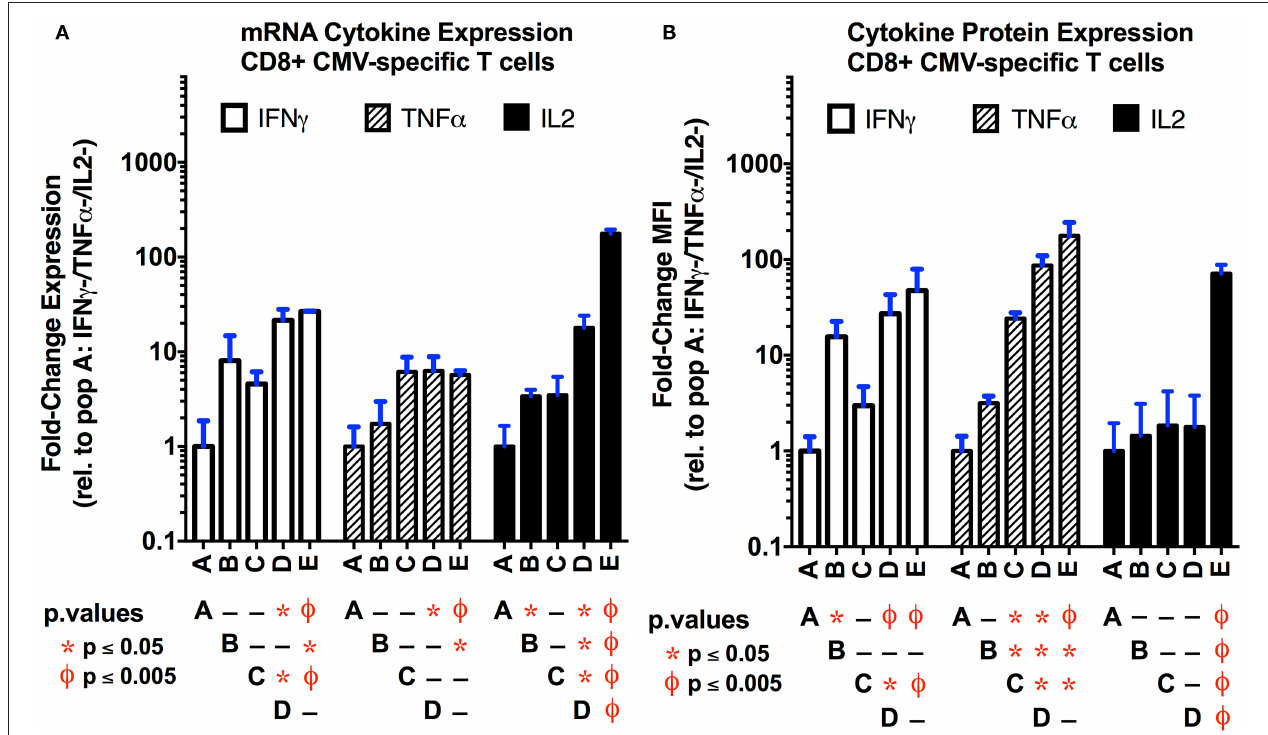
FIGURE 3 | Comparison of cytokine mRNA (A) and protein (B) expression levels in the functional subsets of CMV-specific CD8 + T cells. The mRNA transcript levels for the three primary type 1 cytokines (IFN γ , TNF α , IL-2) were obtained as normalized counts from total RNAseq data, and expressed as the fold-change (log 2 ) compared to the non-functional population ( A ; IFN γ -/TNF α -/IL-2-). The protein expression level (B) was obtained by flow cytometry following intracellular staining for the three cytokines of interest. Data are expressed as the fold-change in mean fluorescence intensity (MFI) relative to the non-functional population ( n = 3 per subset; error bars represent SD). Overall, there is good correlation between the mRNA and protein expression levels. This suggest that, in single cell experiments, the transcription data may be useful to identify functional subsets. Statistical testing: φ p < 0.005; * p < 0.05. Populations: (A) non-functional (IFN γ -/TNF α -/IL-2-); (B) IFN γ only/monofunctional (IFN γ + /TNF α -/IL-2-); (C) TNF α monofunctional (IFN γ -/TNF α + /IL-2-); (D) bifunctional (IFN γ + /TNF α + /IL-2-); and (E) polyfunctional (IFN γ + /TNF α + /IL-2 +